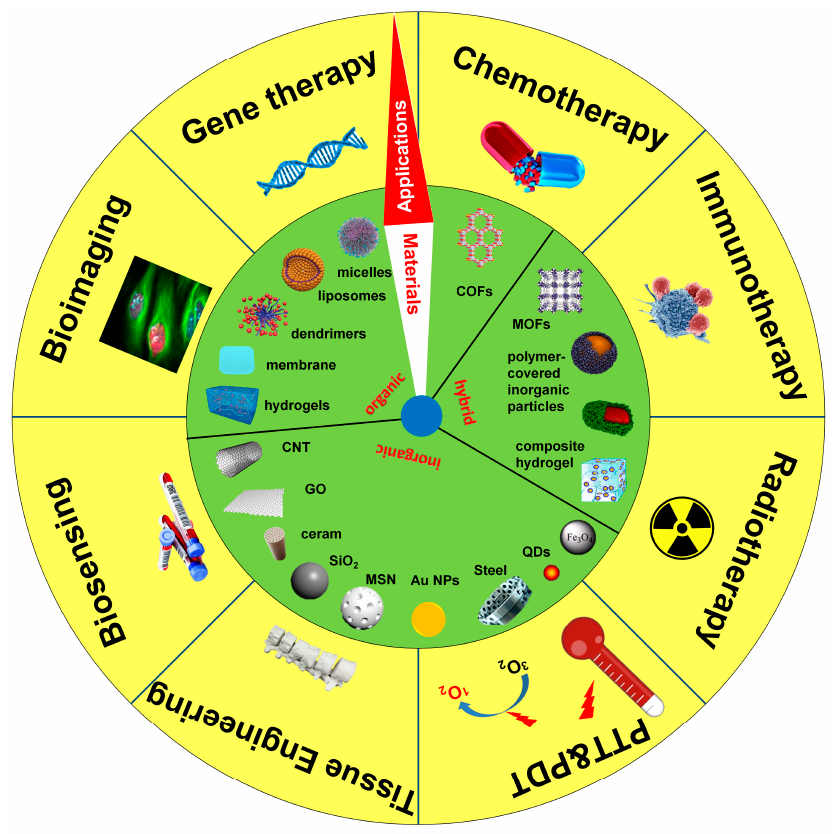
Figure 1. Typical materials for various biomedical applications.